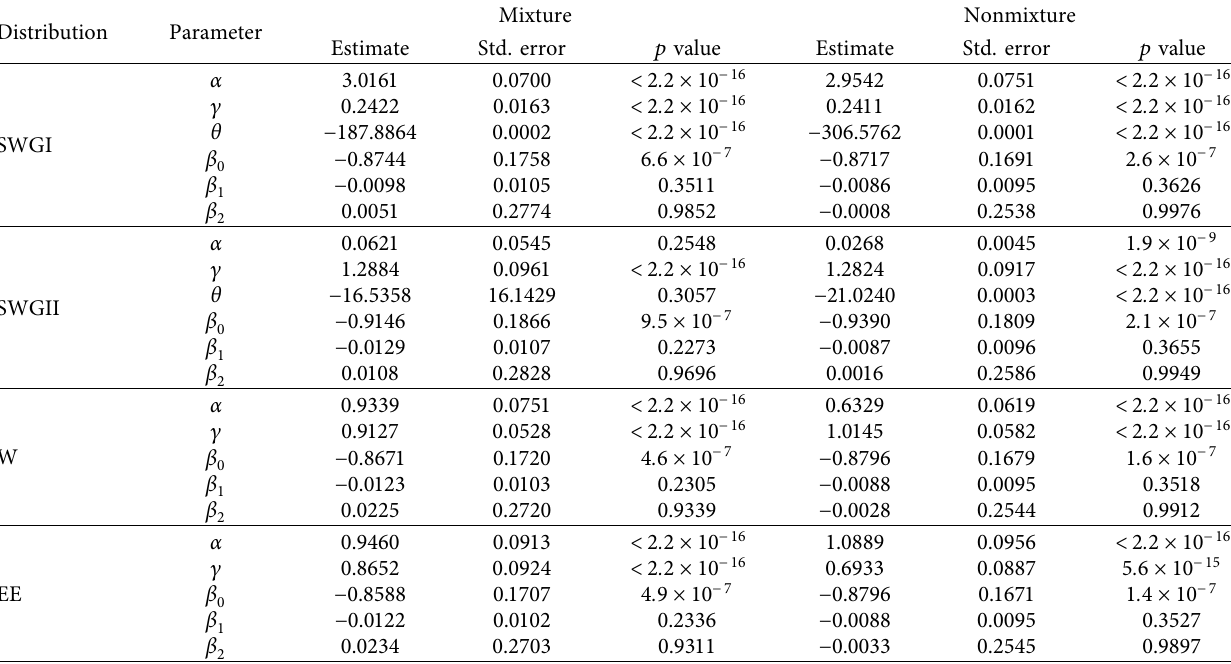
Table 9: Parameter estimates of the regression models.